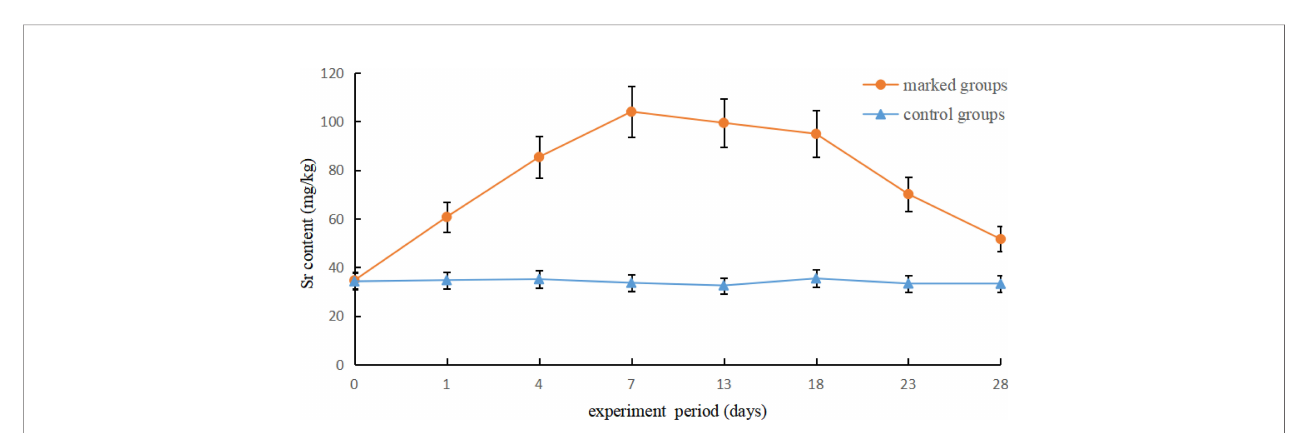
FIGURE 6 | Variation in Sr concentrations between the marked and control groups of Coilia nasus